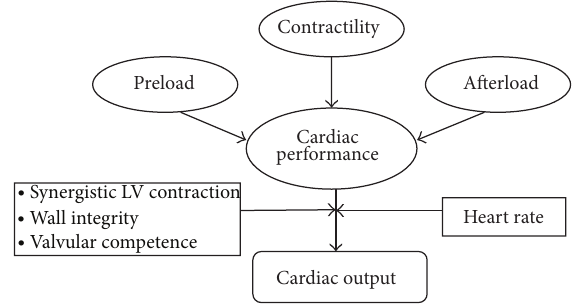
Figure 1: Haemodynamic and intrinsic cardiac factors influencing filling pressure and cardiac